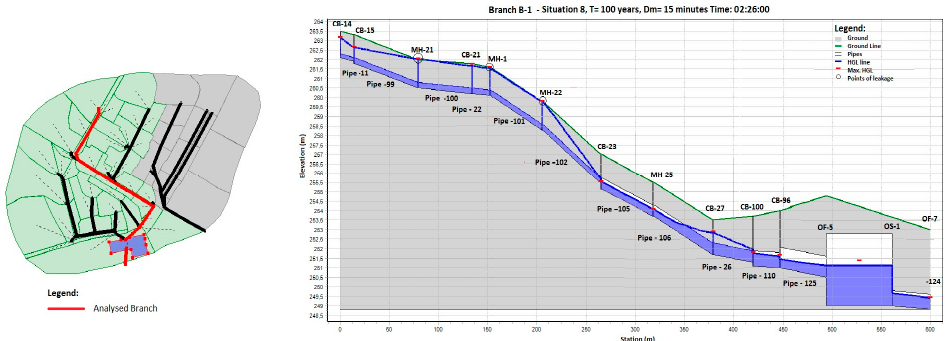
Figure 7. Profile of the main pipe branch after the application of a retention pond in the Scenario 1 ( T = 100 years and Dm = 15 min).